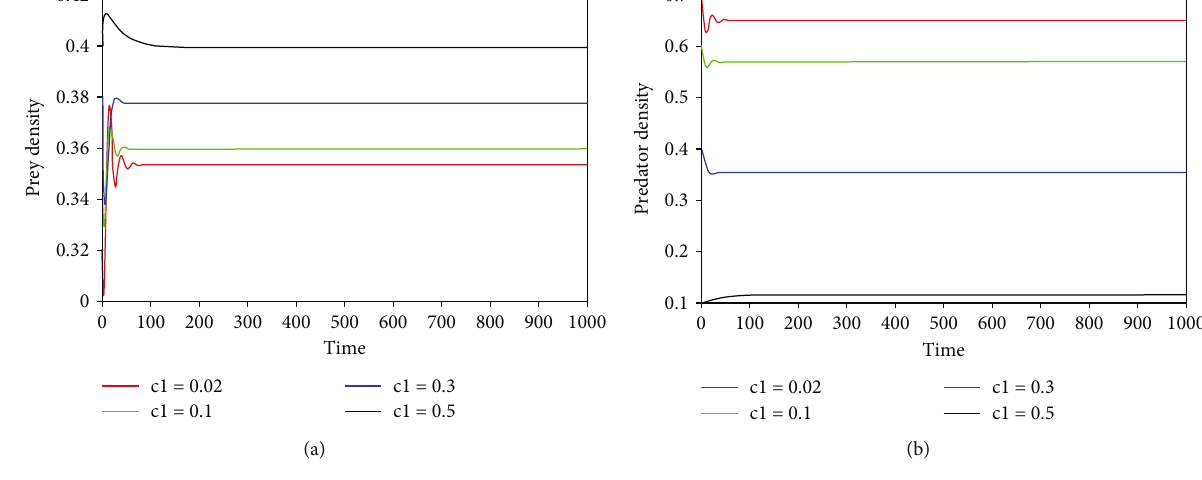
= 0 : 05, α = 0 : 25, and β = 0 : 2 and c = 0 : 02,0 : 1,0 : 3,0 : 5 , 2 1